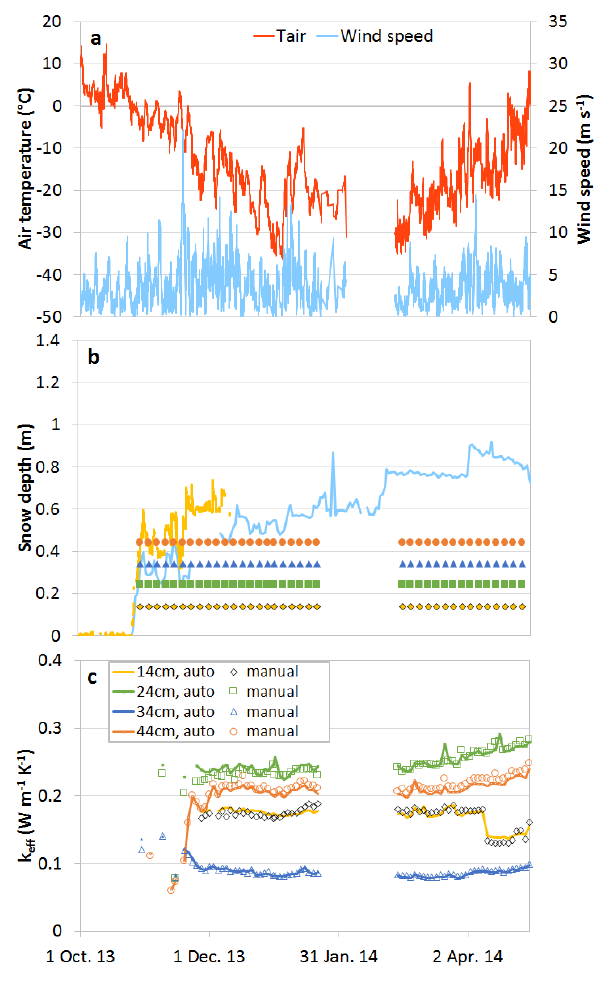
Figure 5. Meteorological and thermal conductivity data automat- ically recorded during the winter 2013–2014. A battery failure caused the loss of meteorological data between 3 and 28 Febru- ary and of the thermal conductivity data between 23 January and 28 February. (a) Air temperature and wind speed; (b) snow height and NPs height. The snow gauge close to the NPs (yellow line) broke. We therefore show data from another snow gauge located about 20m from the NPs. Because of topography, the snow heights differ at both spots; (c) k eff time series.